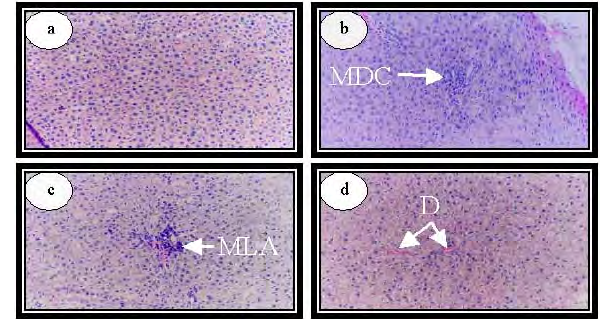
Figure 6 : Histopathology of liver from female rats treated with saline (a) showing normal hepatic parenchyma; AcAaIT (b) showing mild reversible degenerative changes (MDC) in a few hepatocytes; AcMNPV (c) showing mild leukocyte aggregation (MLA) in the portal area; and SlNPV (d) showing vascular and hydropic degeneration (D) of some hepatocytes (H&E x300).